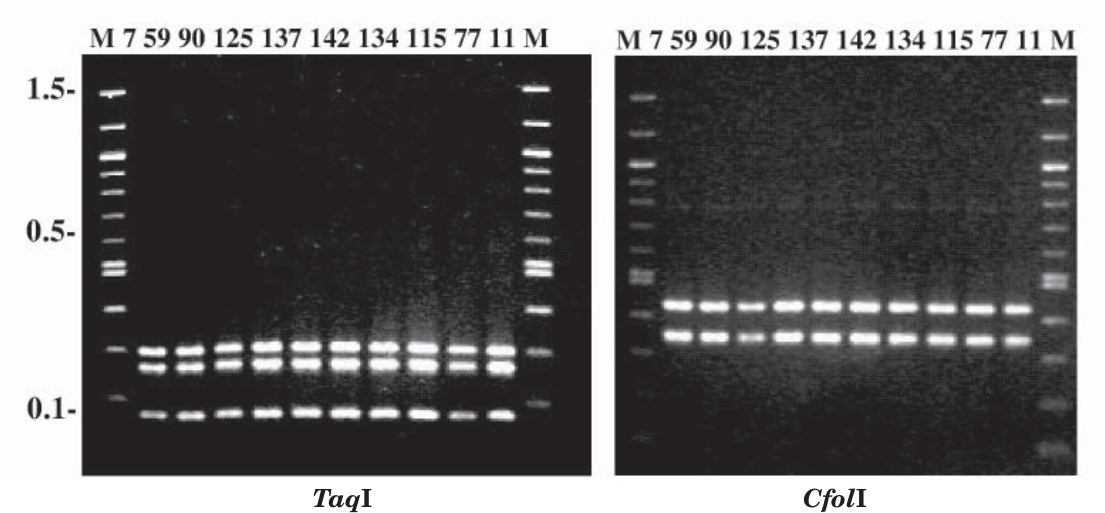
Fig. 5. Restriction profiles obtained with the enzymes Taq I, Cfo I by amplification of the ITS region of rDNA of Phellinus torulosus isolates. In the migration lanes the following are shown from left to right: M, 100 base pairs marker ladder and code of the P. torulosus isolates